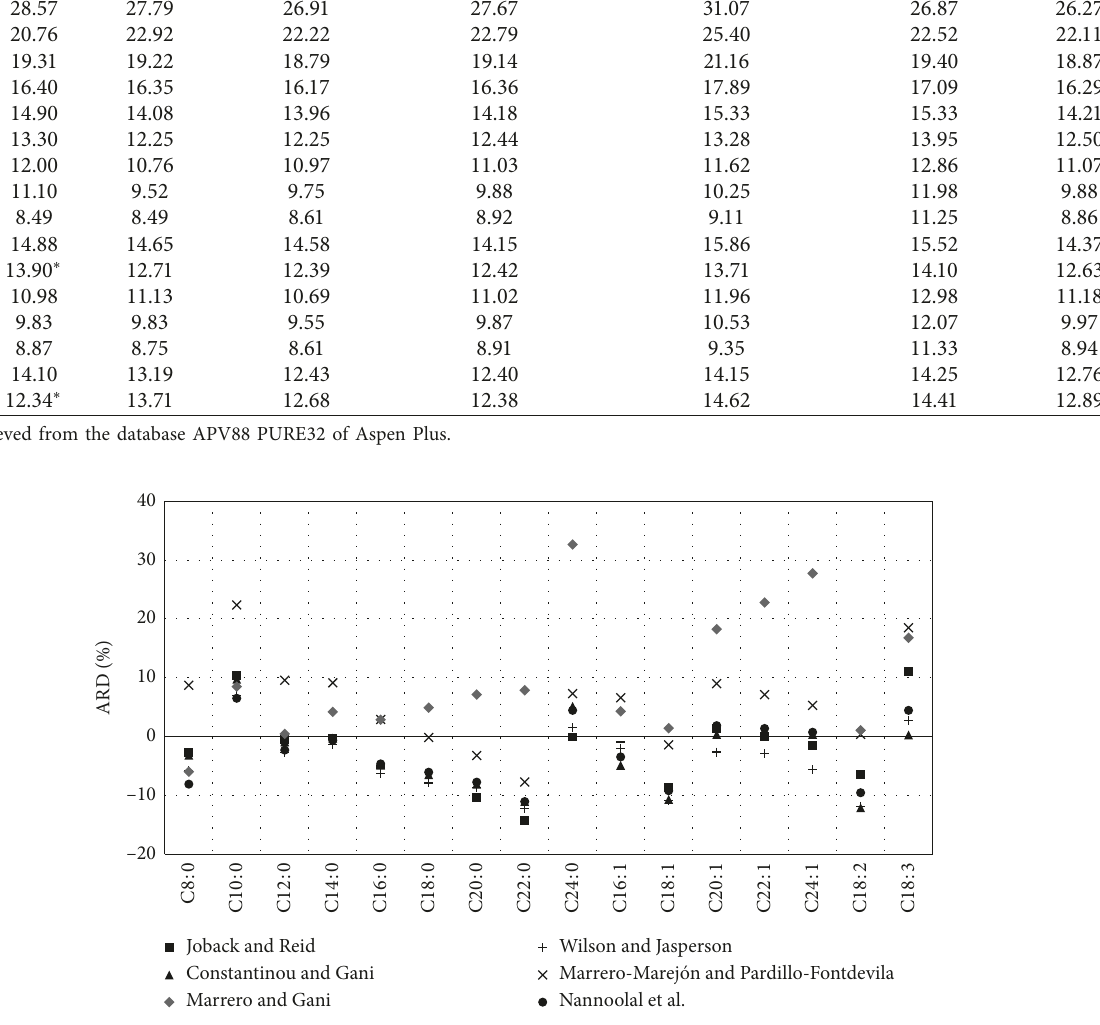
Figure 7: Absolute relative deviation of estimation for the critical pressure. Table 15: Deviations of different methods for the estimation of the critical